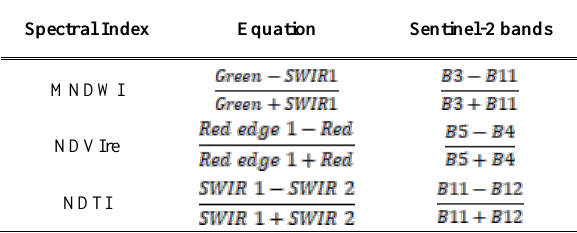
Table 2 . Spectral indices calculated in this study.